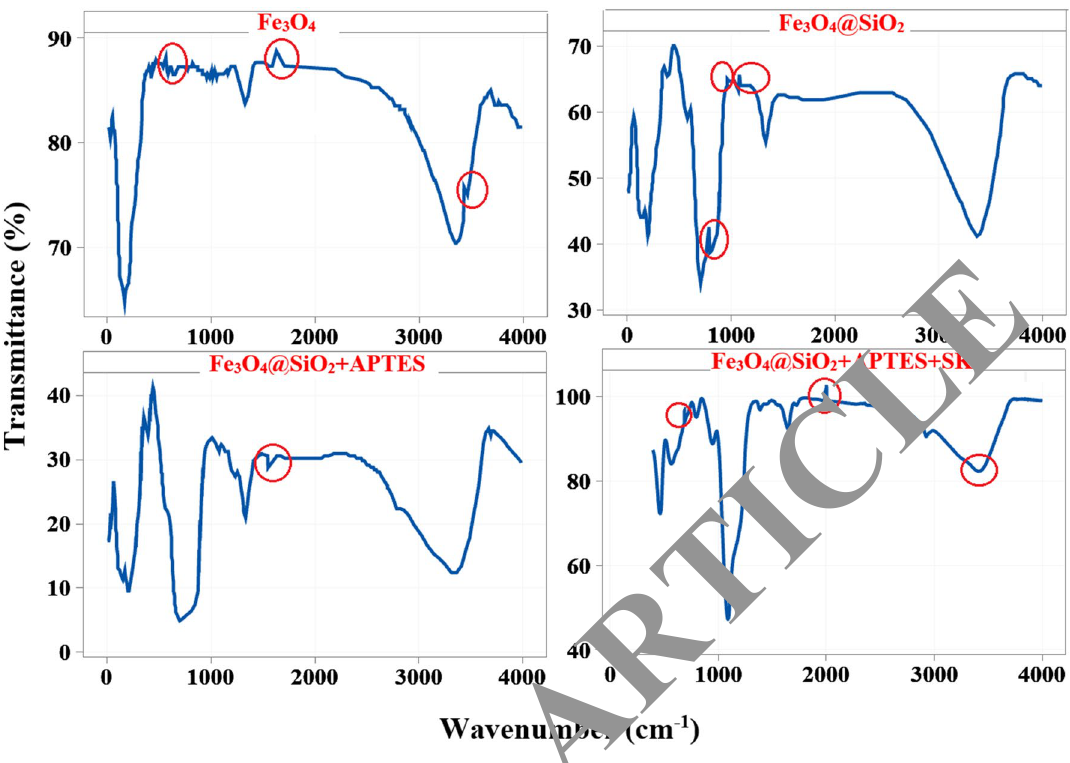
Figure 3. FTIR spectra of Fe 3 O 4 , Fe 3 O 4 @SiO 2 , Fe 3 O 4 @SiO 2 + APTES and Fe 3 O 4 @SiO 2 + APTES +